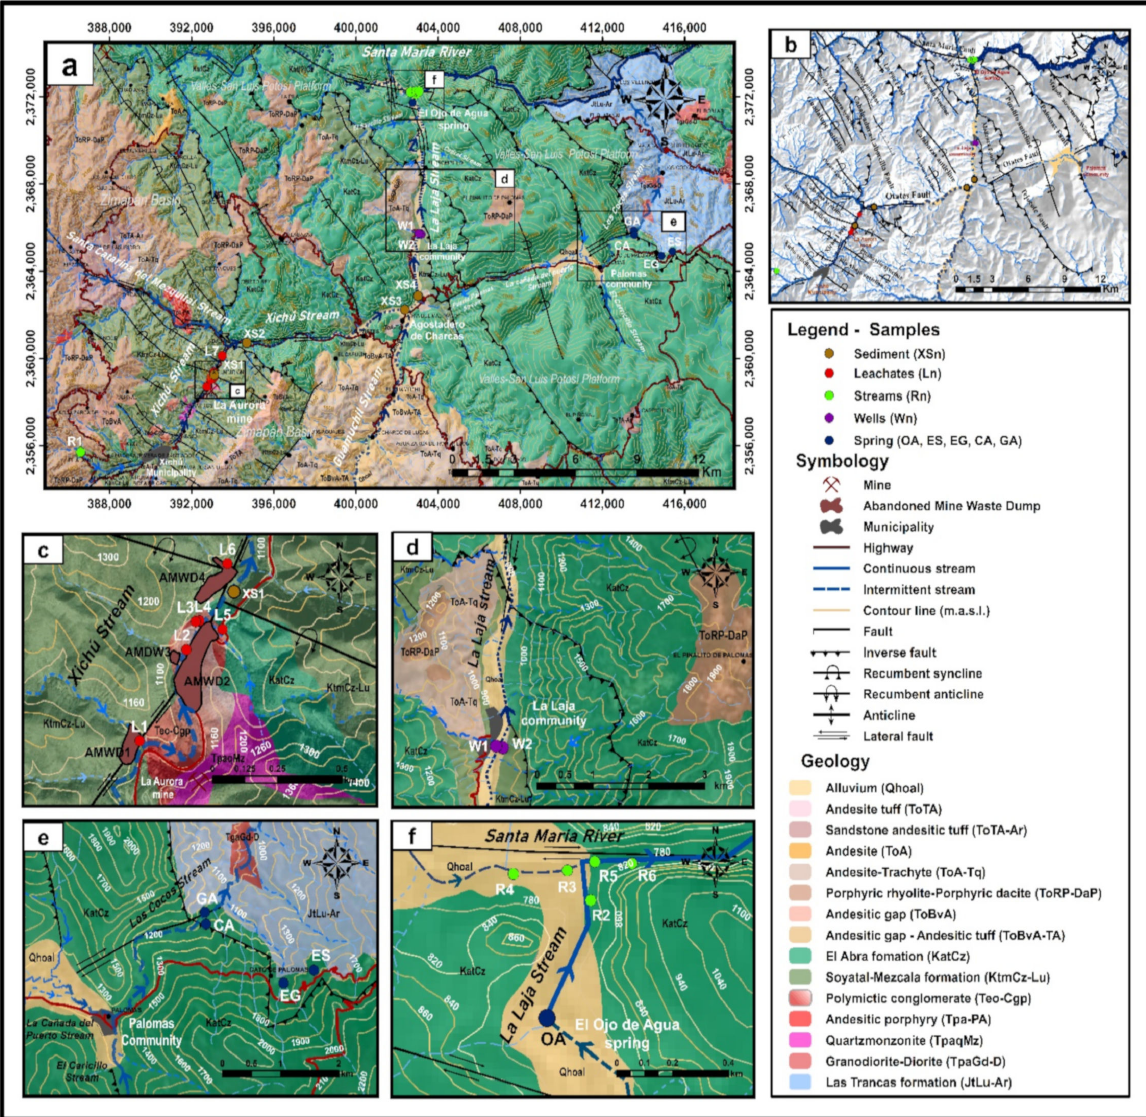
Figure 1. ( a ) Map of the study area and location of the collection of water and sediment samples. ( b ) Geological structural map representing the main fault, orography, and hydrography context. ( c ) Close-up view of the wastes area. ( d ) Close-up view of the La Laja community area. ( e ) Close-up view of the Palomas community area. ( f ) Close-up view of the confluence between the El Ojo de Agua spring and the Santa Mar í a River. The labels identify the sampling points by the type of stream body or the stream sediments, or both (based on data from the geological maps of Arredondo-Mendoza et al. [32] and Gonz á lez-Ramos and Rodr í guez-Moreno